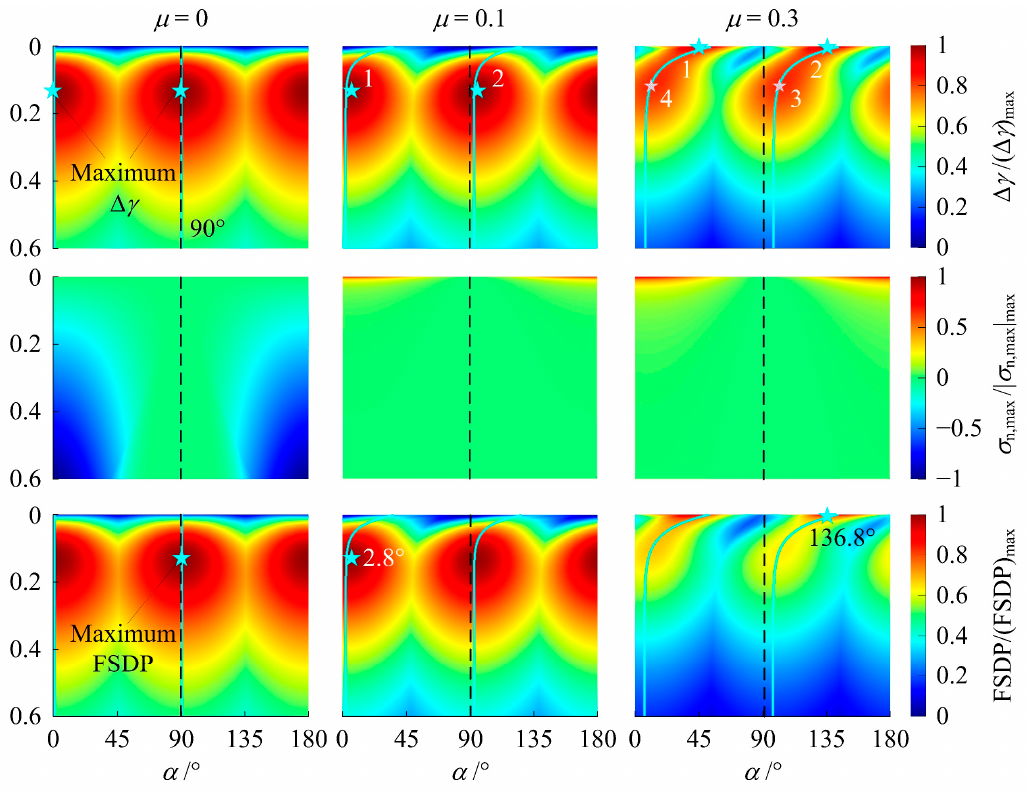
Figure 6. The contour of ∆ γ / ∆ γ max , σ n,max /| σ n,max | max and the Fatemi–Socie damage parameter (FSDP)/(FSDP) max for P / P rated = 1 and µ = 0, 0.1, and 0.3.